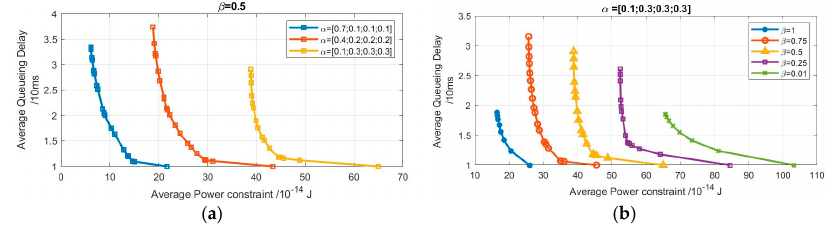
Figure 9. BACA system suboptimal tradeoff curves for: ( a ) 𝛽 = 0.5 ,( b ) 𝛼 = [0.1,0.3,0.3] .